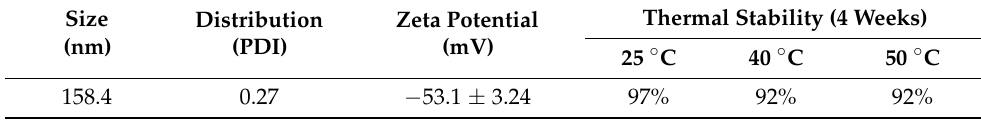
Table 4. Mean size, PDI value, zeta potential, and stabilities at various temperatures of